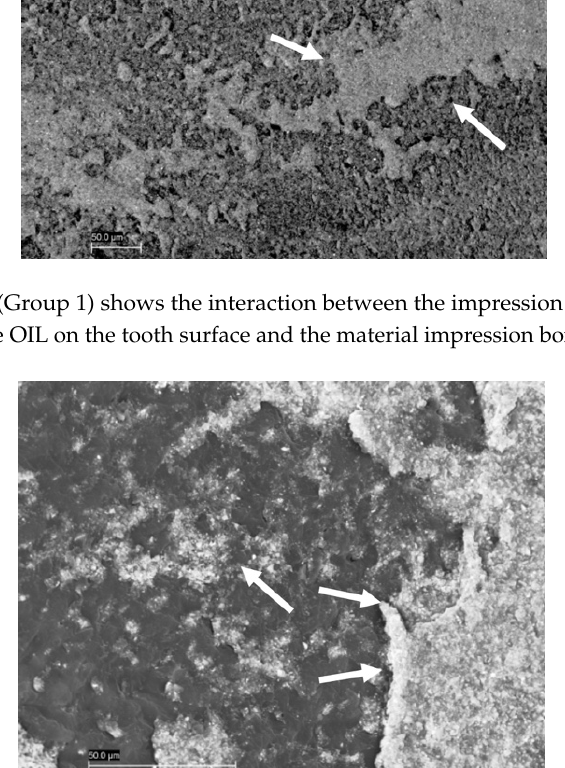
Figure 5. This image (Group 1) shows the interaction between the impression material and OIL. It is